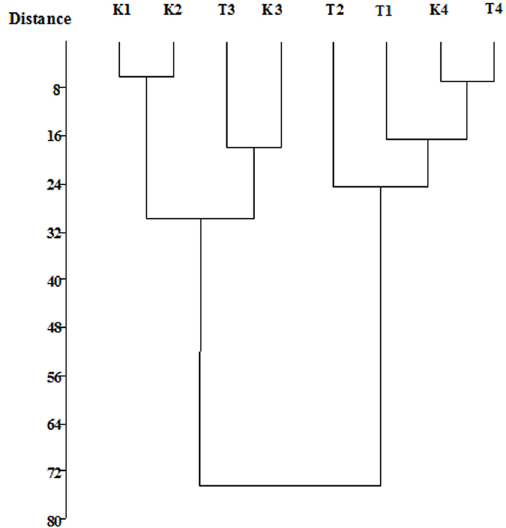
Figure 4. Cluster analysis indicated functional similarity in the lower zone (K3-T3) and mouth zone (K4-T4) of both the